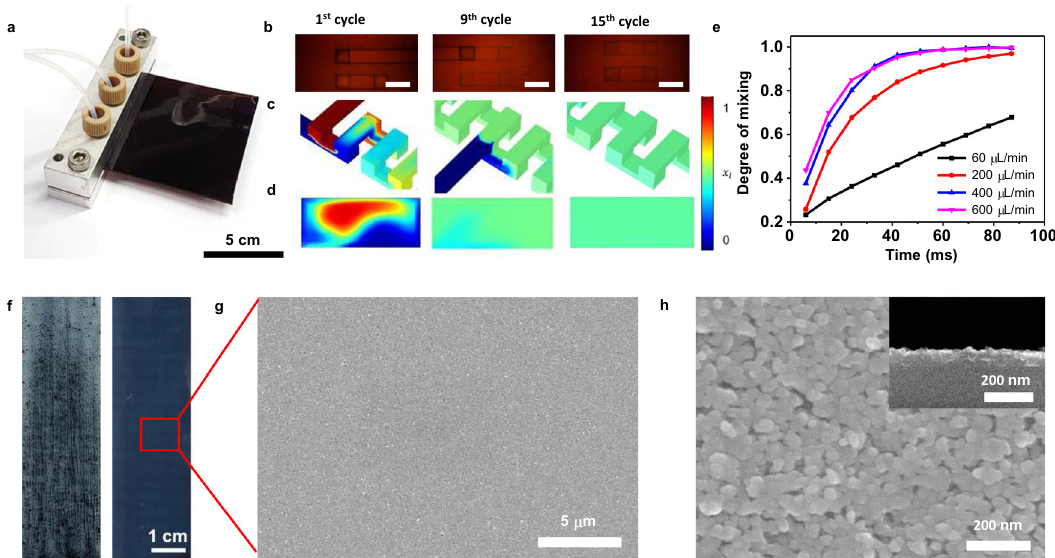
Fig. 2 Characterization of MiCS. a Photographic image of the polyimide micro fl uidic blade. b Optical image of polyimide micro fl uidic device channel (scale bar: 500 mm): 1st cycle (left), 9th cycles (middle), 15th cycles (right). c 3D surface and d 2D cross-sectional concentration distribution of solution ( x l ) at 1st (left), 9th (middle), and 15th (right) cycle under 660 μ L/min fl ow rate. e Effect of cycle number on the degree of mixing obtained at various fl ow rates. f Optical image of solution sheared Pt@Cu 3 (HHTP) 2 fi lm (shearing speed at 2mm/s) on glass substrate at 150°C: without micro fl uidic blade (left), and with micro fl uidic blade (right). g , SEM image of Pt@Cu 3 (HHTP) 2 thin fi lm. h High-resolution SEM image of Pt@Cu 3 (HHTP) 2 thin fi lm. @ means